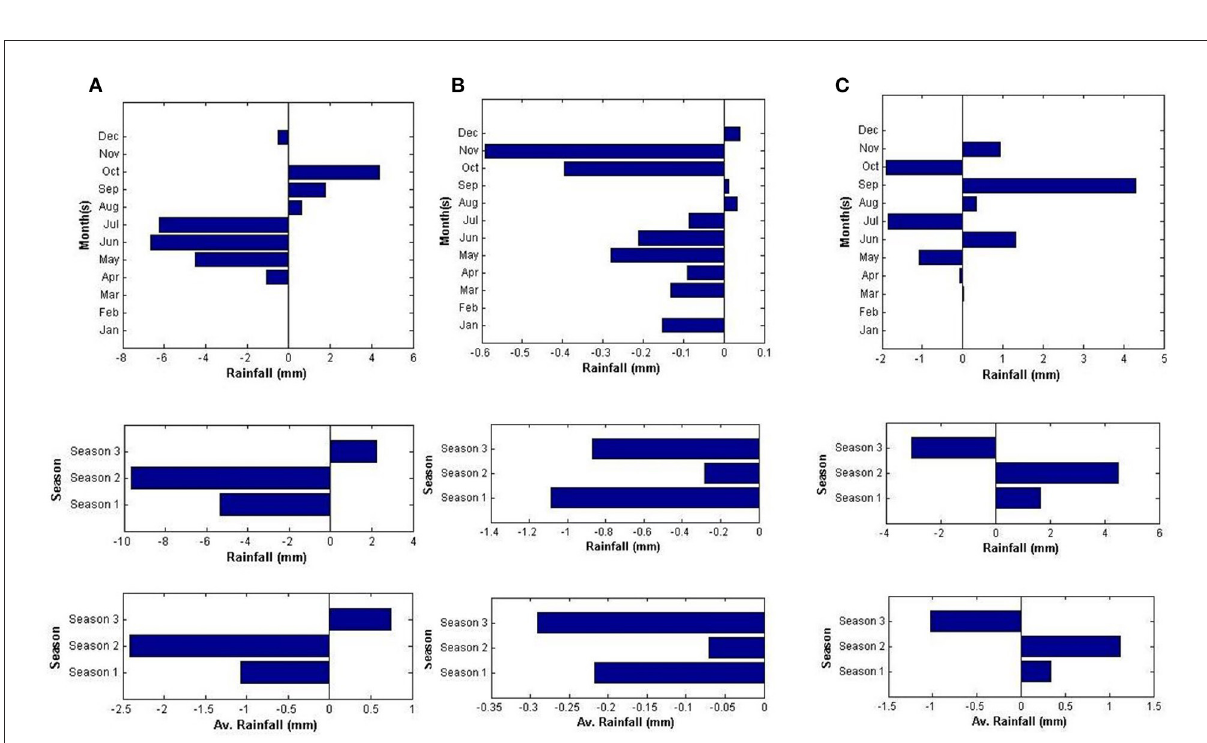
FIGURE2 Sen slopes of trends in climatic variability in (A) , CH, Kerala; (B) , LPH (Manalur), Tamil Nadu; (C) , KH,